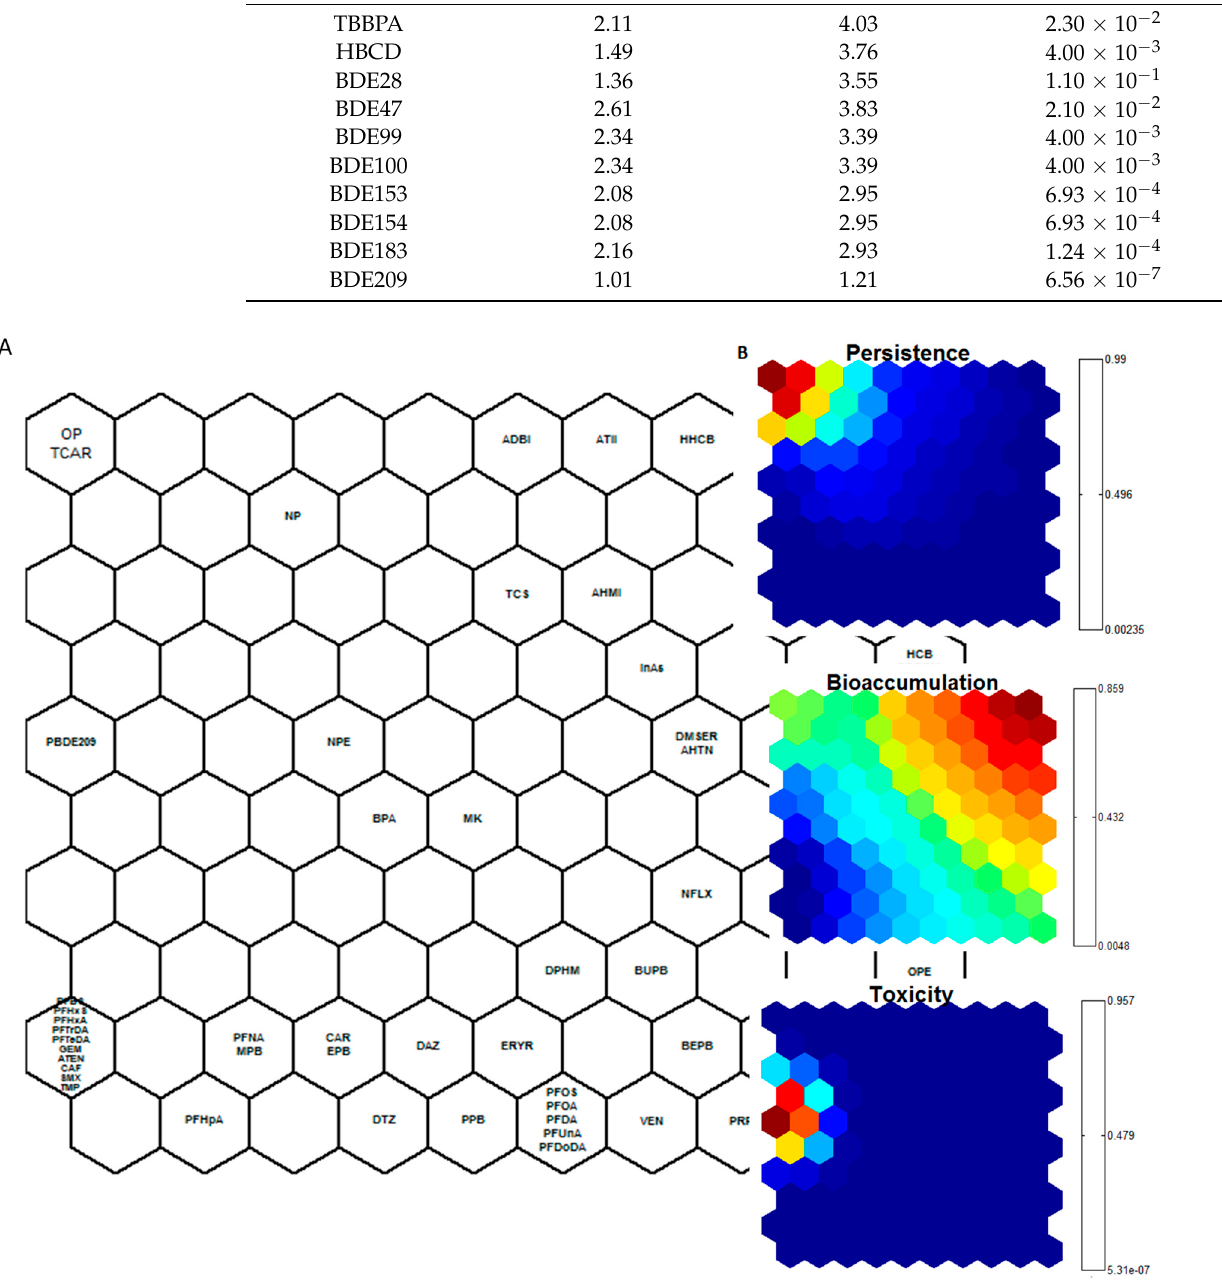
Figure 1. Self-Organizing-Maps of the hazard index (HI): ( A ) Labeled cluster of Kohonen’s map; ( B ) c-planes of PBT. Grouping based on PBT parameters (persistence, bioaccumulation and toxicity) values of the pollutants under study. For definitions of compound abbreviations refer to Table 1. Color intensity shows numeric strength of index, the brighter the color, the higher the value. The label display shows positions of each unit on the map.